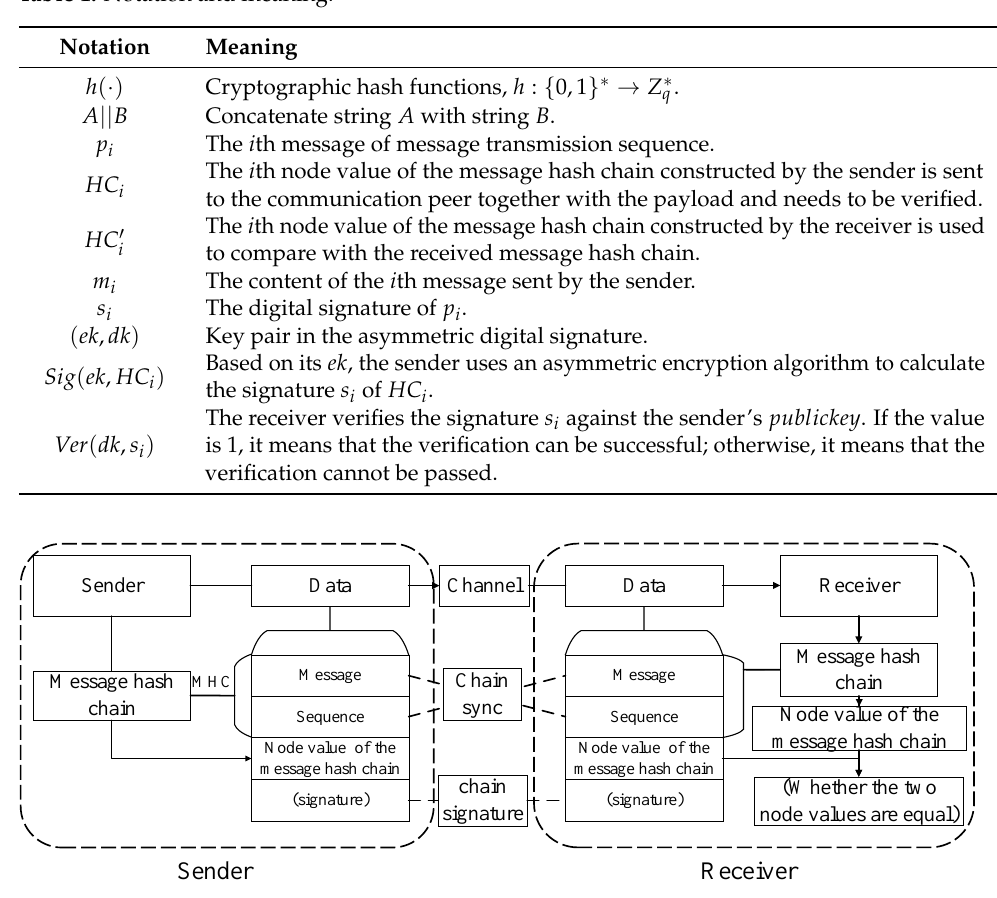
Figure 1. Message hash chain communication